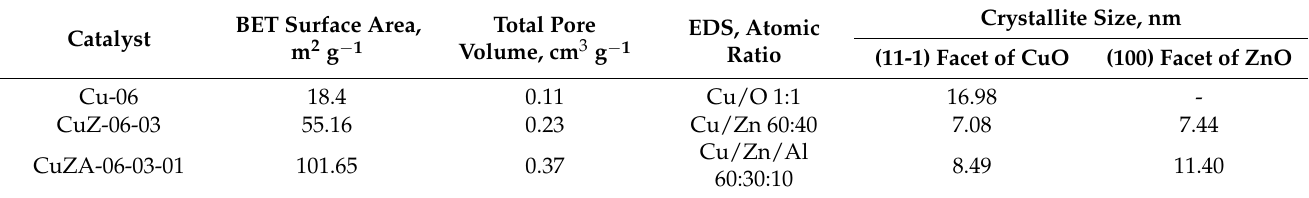
Table 3. Amount of Cu, Zn, and Al by ICP in the investigated samples.